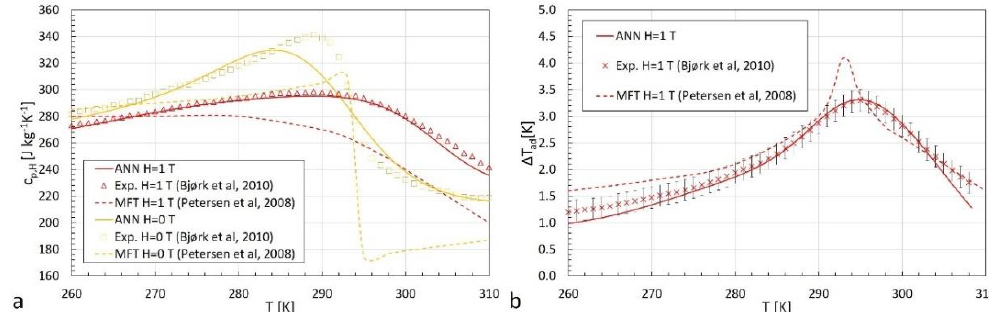
Figure 6. Comparison with MFT approach: ( a ) Measured values of specific heat of Gd at H = 1 T and H = 0 T in comparison with values predicted by the MFT approach and ANN-based procedure, ( b ) Measured values of the adiabatic temperature change of Gd at H = 1 T in comparison with the values predicted by the MFT approach and the ANN-based procedure.